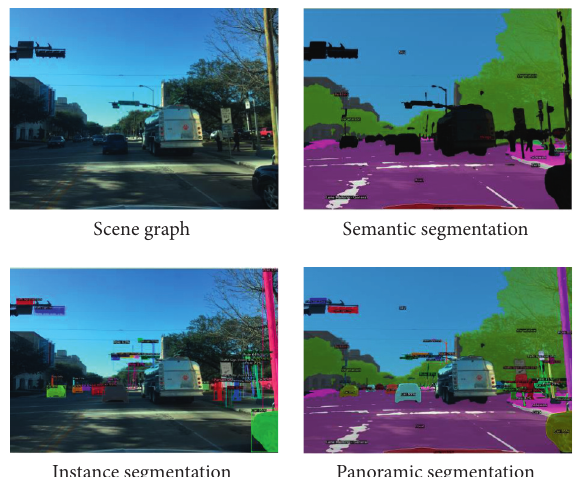
Figure 8: Panoramic segmentation instance results. (a) Scene graph. (b) Semantic segmentation. (c) Instance segmentation. (d) Panoramic segmentation.